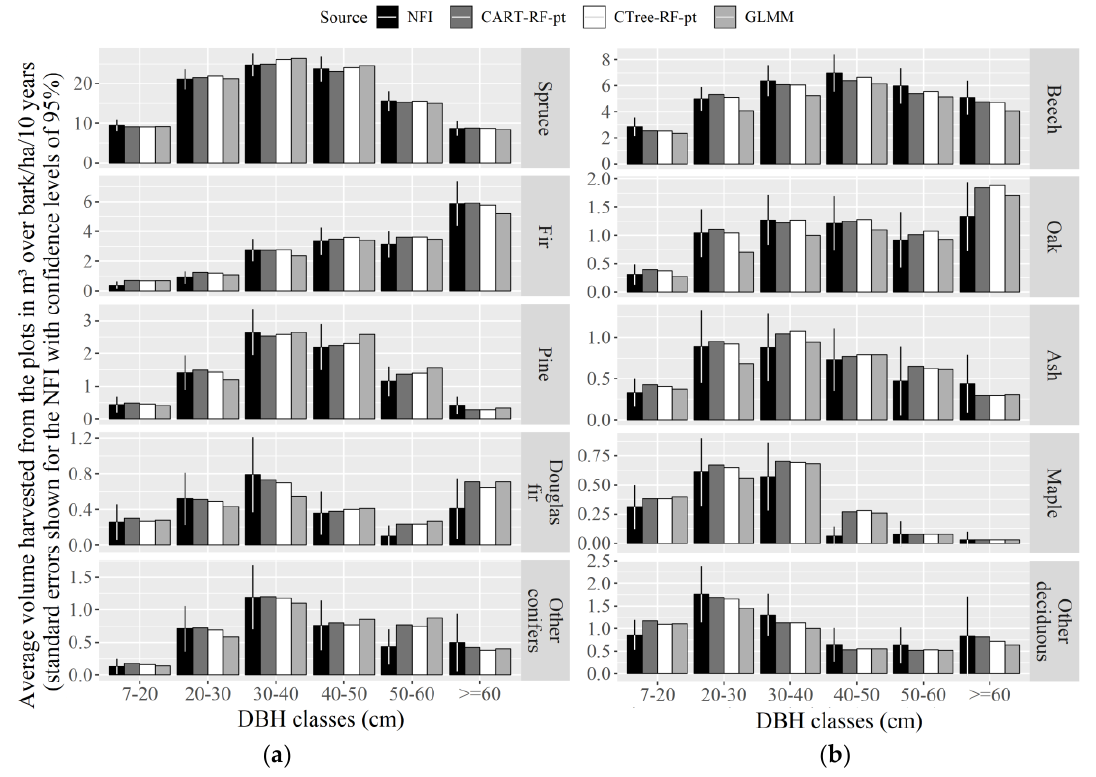
Figure 1. Comparing predicted average harvested volumes to national forest inventory (NFI) measurements on species level for the period 2002–2012. ( a ) Conifer species. ( b ) Deciduous species. Harvested volumes refer to the average of the 1,894 test set plots. The reference year for the diameter at breast height (DBH) classes and harvested volumes was 2007 (CART: Classification and regression tree; CTree: Conditional inference tree; RF: Random forest; pt: variation that used plot- and tree-level attributes; GLMM: Generalized linear mixed model).